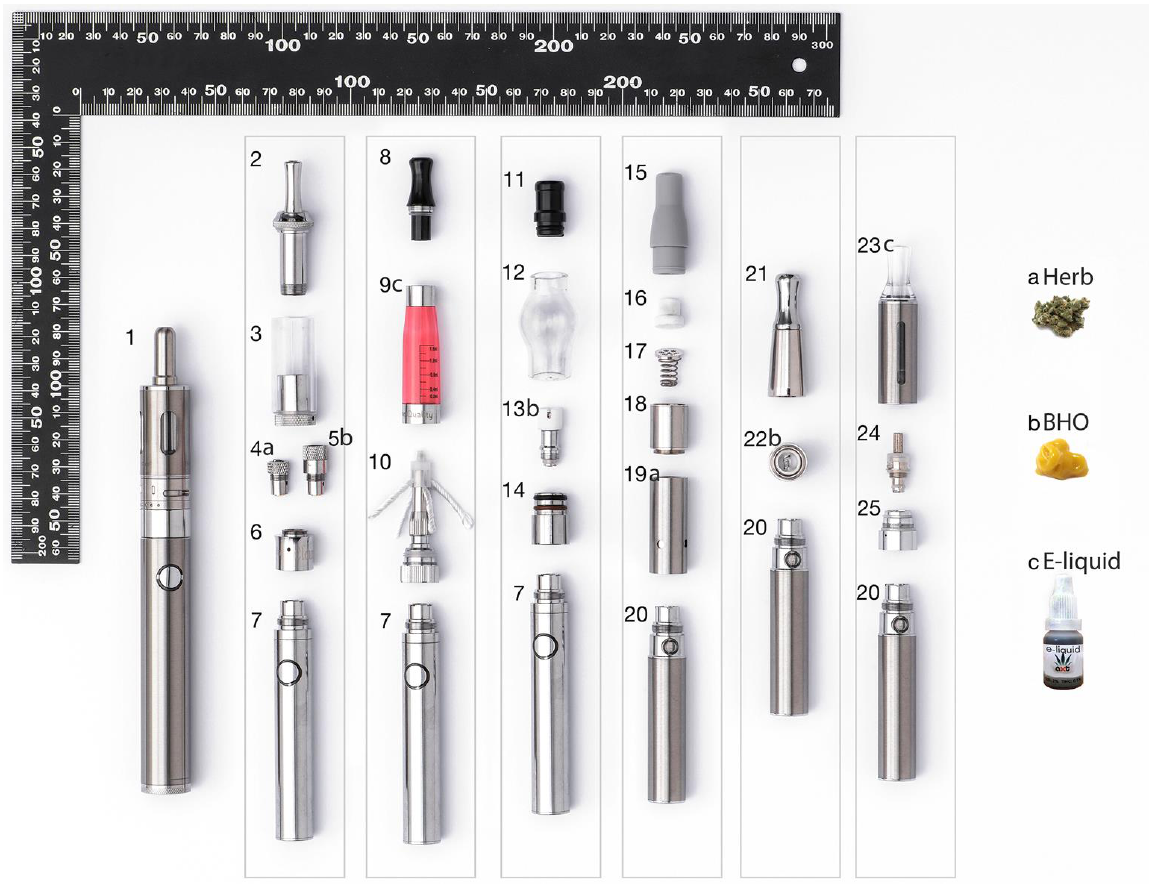
Figure 2. Some models of e-cigs for vaping ( a ) ground marijuana head tops; ( b ) cannabis wax (butane honey oil concentrate (BHO)), or ( c ) cannabis e-liquid. The letters a, b, or c after the numbers indicate the parts of e-cigs used for herb, BHO, or e-liquid vaping, respectively. 1. Mega electronic cigarette (e-cig) with dual-coil clearomizer, adjustable airflow control ring, changeable resistance coils and high capacity, variable voltage battery. 2–7. Dry herb and wax vaporizer: 2. Spring-loaded mouthpiece; 3. Vaporizer chamber; 4. Dry herb coil head; 5. Wax coil head; 6. Detachable base with air holes; 7. Medium capacity battery. 8–10. See-through clearomizer for e-liquids: 8. Clearomizer tip; 9. Clearomizer tube; 10. Clearomizer coil and four-wick head with base assembly. 11–14. Glass-globe atomizer wax tank: 11. Drip tip; 12. Glass globe; 13. Ceramic heating chamber and coil; 14. Metal core. 15–19. Dry herb atomizer: 15. Soft drip tip (mouthpiece); 16. Ceramic screen; 17. Metal screen and spring; 18. Screens connector; 19. Ceramic chamber and battery connector. 20. Medium size battery. 21–22. Wax coil head atomizer: 21. Metal mouthpiece and wax coil chamber connector; 22. Wax coil ceramic chamber and battery connector. 23–25. Clearomizer for e-liquids: 23. Shell (mouthpiece attached to metal tank with viewing window); 24. Bottom head changeable coil assembly; 25. Battery base connector. a. Marijuana head tops, b. Cannabis Butane Honey Oil concentrate (BHO), c. Cannabis e-liquid (mixture of cannabinoid concentrates (cannabis wax), propylene glycol and